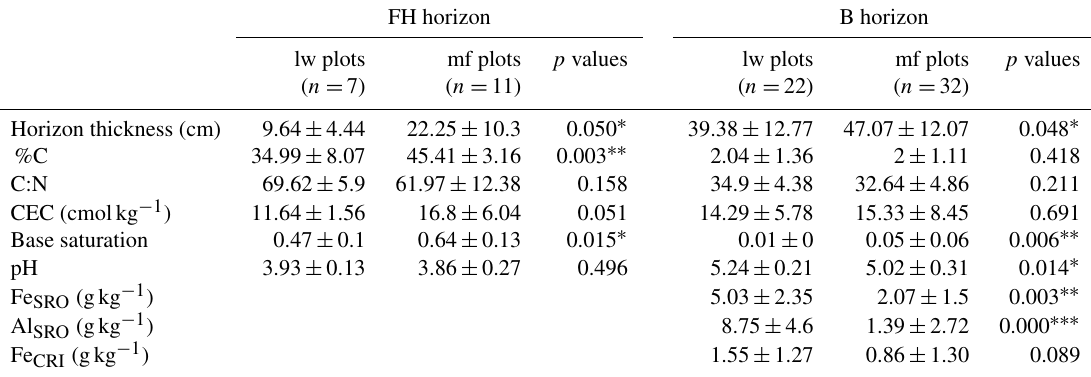
Table 2. Characteristics of FH and B horizons in mf and lw plots. The lw plots are plots covered by lichen woodlands, and the mf plots are plots covered by moss forests. Values are given as means ± standard deviations. “SRO” stand for short-range order species and “CRI” for crystalline species. Asterisks indicate statistical significance using mixed models (see Materials and methods), with ∗ p value<0.05, ∗∗ p value<0.01 and ∗∗∗ p